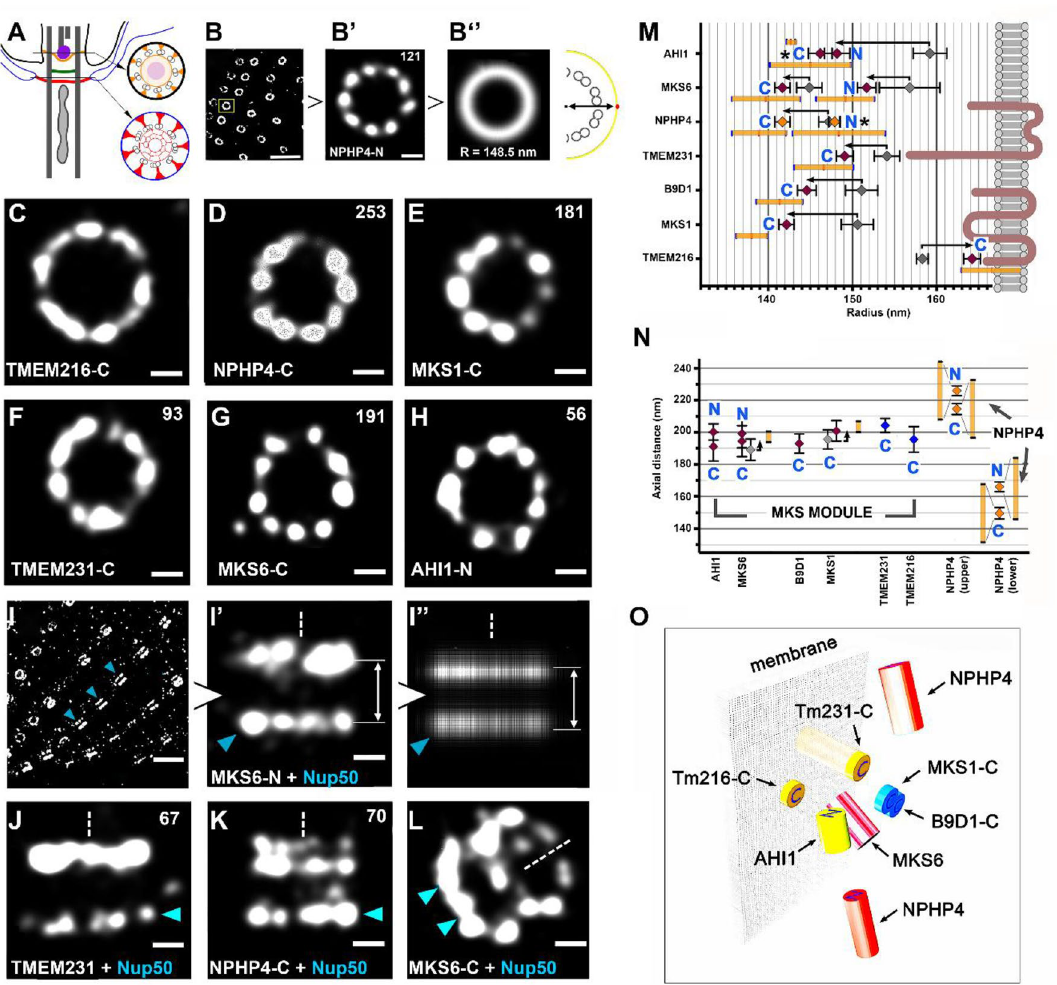
Figure 1. Localization of the transition zone proteins. ( A ) The TZ of Tetrahymena thermophila . The TZ in Tetrahymena comprises three plates: distal, intermediate, and terminal. The distal plate (in orange) is positioned just below an axosome (in violet), the electron-dense area anchoring one of two central microtubules. The cross- section at the distal plate shows sites known as a ciliary necklace, nine clusters of the electron-dense material connecting the outer doublets with the ciliary membrane. The terminal plate (in red) is the most proximal plate of the TZ and marks the border between basal body and cilium. At the level of the terminal plate, the outer doublet microtubules are connected with the membrane of the alveoli (flattened cisternae that underlie plasma membrane, here in blue) by nine clusters of the electron-dense material resembling inverted triangles. The central part of the terminal plate has a characteristic “lace-like” structure (drawing was prepared based on the TEM images from 90,91 ). Please see also TEM localization studies of TZ proteins in Paramecium summarized in G 76 . ( B – B ′′ ) Overview of image collection and processing method for top view images. ( B ) Low magnification view of the surface of a Tetrahymena cell expressing a tagged TZ component. ( B ′ ) Higher magnification of a single cilium base at the TZ level in cells expressing N-terminally tagged NPHP4. ( B ′′ ) Image of tagged NPHP4 averaged from 121 cilia bases. To the right is a schematic representation of the radial position (R). ( C–H ) STORM images of the top view of six TZ fusion proteins (as indicated) with either N- or C-terminally attached 3HA tag. ( I–I ′′ ) Overview of image collection and processing method for side view images. NUP50 was used as a stipulated reference marker and indicated by a blue arrowhead. ( J,K ) Examples of side views for two proteins as indicated. NUP50 positive ring indicated by a blue arrowhead. ( L ) Oblique view of MKS6 with a C-terminal 3HA tag. Dashed line indicates cilium axis. A NUP50-positive ring indicated by blue arrowheads. ( M ) Radial positions of TZ proteins localized using direct (indicated in colored diamonds) and indirect (indicated in grey diamonds) staining. Black arrows indicate differences between the two localization methods and show the shift between the two measurements. Asterisks indicate no statistically significant difference between direct and indirect measurements. ( N ) Axial positions of TZ proteins relative to NUP50. Note that MKS and NPHP4, a component of the NPHP module, proteins localize differently. Yellow bars in ( M,N ) show the uncertainty of epitope locations. ( O ) A 3D model of analyzed TZ proteins. Scale bars in ( B,I ), 1 µm; in ( B ′ , C–H , J–L ), 100 nm. In ( B ′ ,C–H,J,K ), the numbers of rings (or side views) used to calculate the average radius (or axial distance ) of each protein are shown (top right). The rings/side views were collected from at least 10 different cells from 3 independent